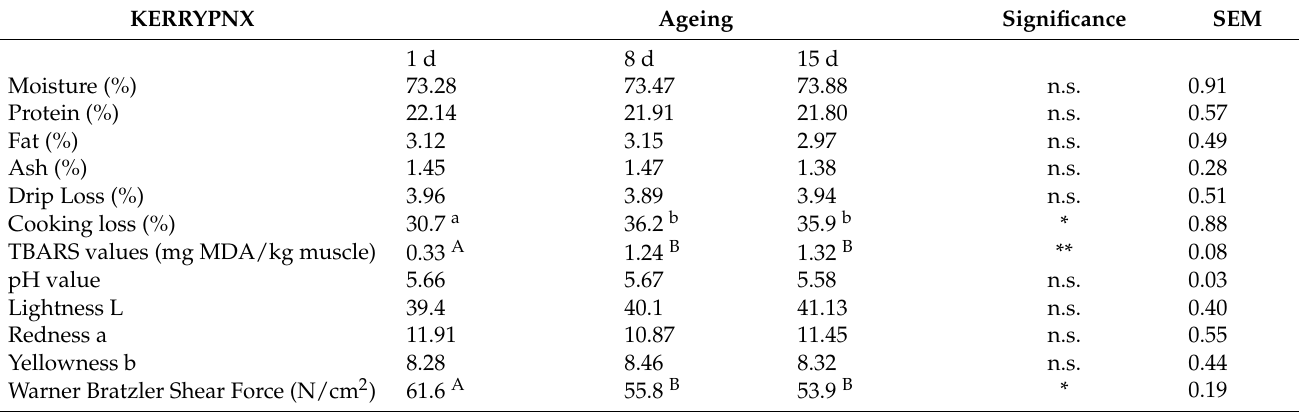
Table 1. Chemical and physical donkey meat parameters determined at different ageing